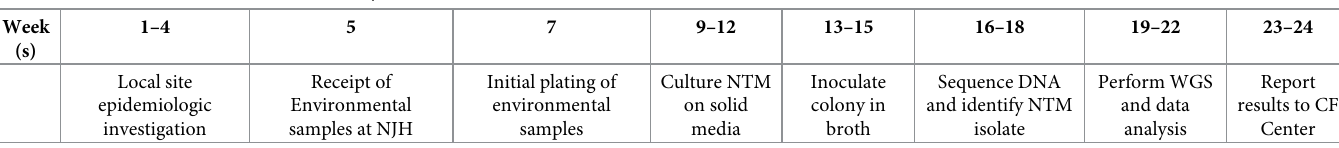
Table 3. Timeline of data collection and